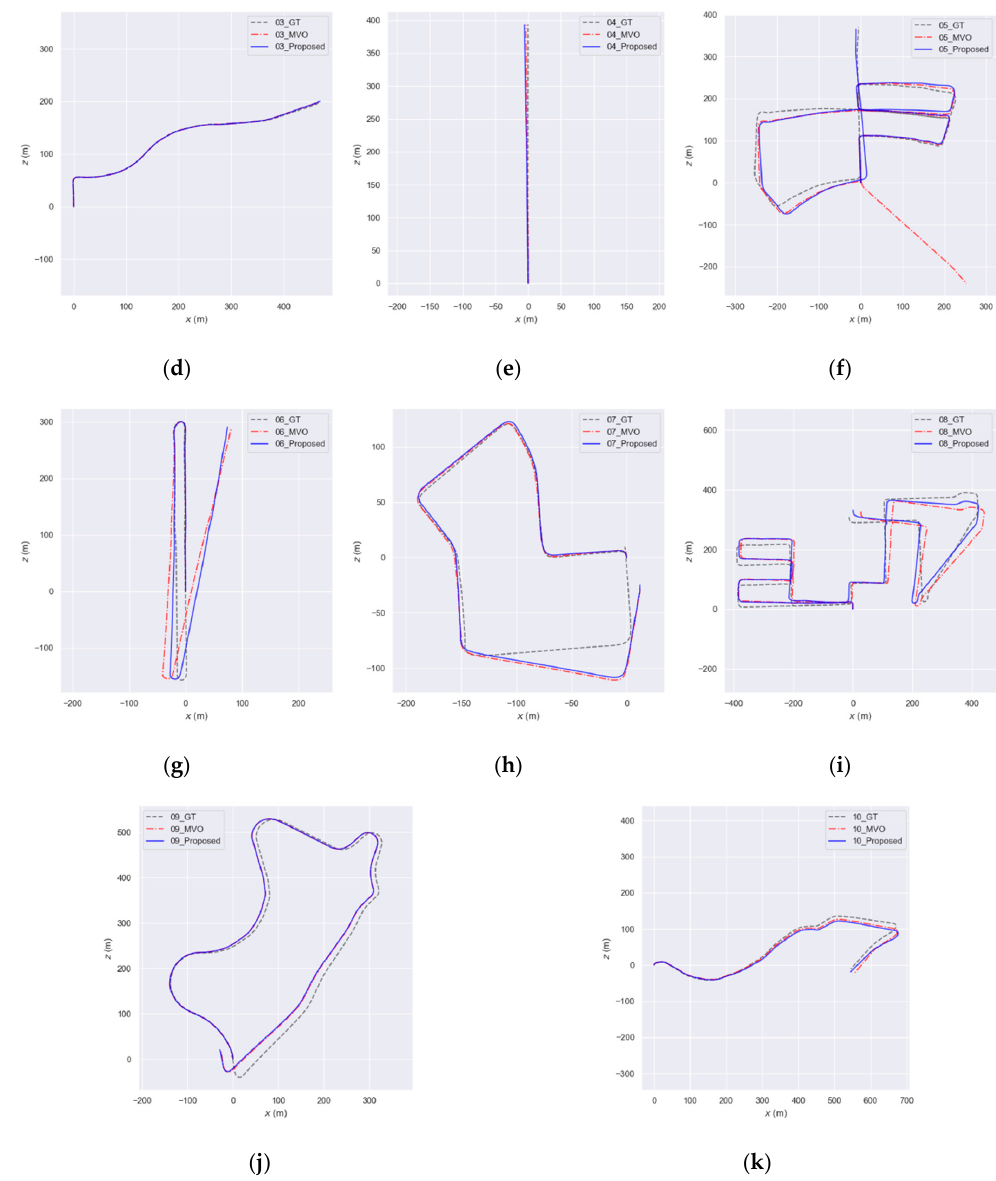
Figure 12. Trajectory of KITTI sequences 00 to 10 about ground truth (GT), MVO, MVO with the proposed method (00 to 10 sequence in alphabetical order ( a – k )).